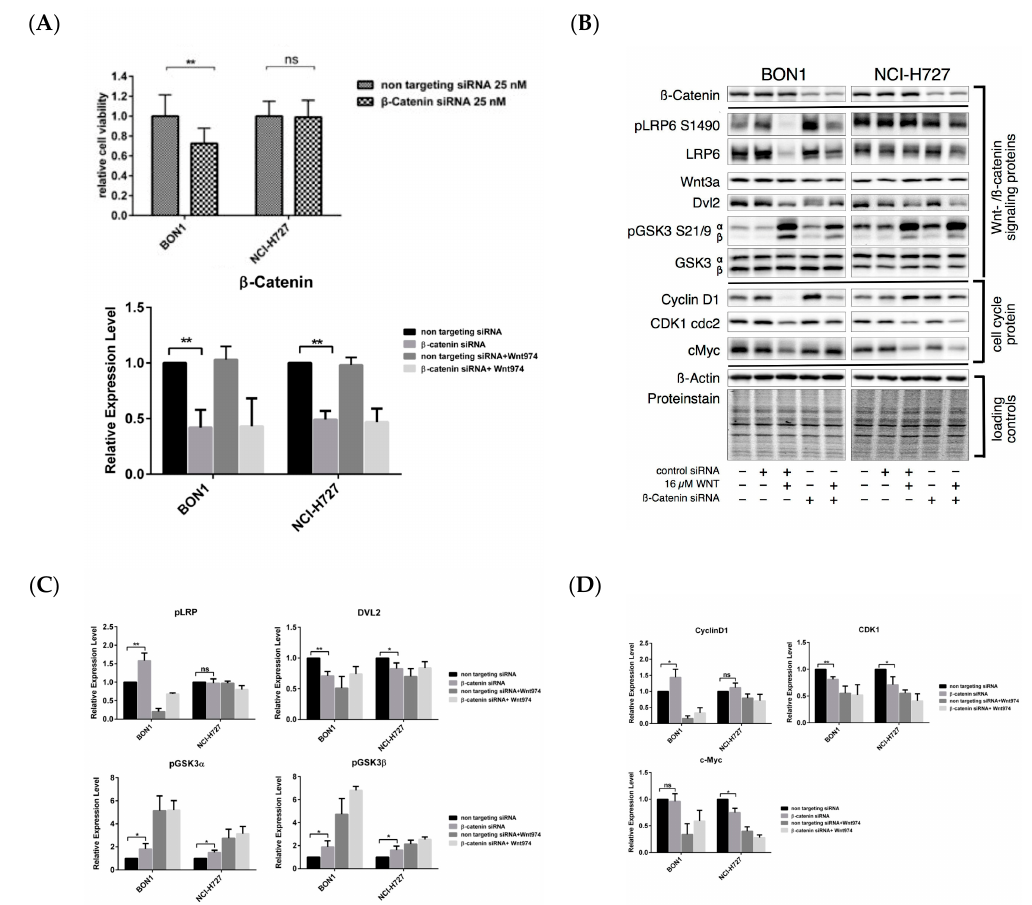
Figure 9. E ff ect of β -catenin siRNA on the reduction of NET cell viability and protein expression. BON1 and NCI-H727 cells transfected with β -catenin siRNA or non-targeting control ( β -actin) siRNA for 72 h and then subjected to cell viability assay and Western blot analysis. ( A ) Cell viability assay and siRNA transfection e ffi cacy. BON1 and NCI-H727 cells were transfected with β -catenin siRNA or non-targeting control ( β -actin) siRNA for 72h and then subjected to the cell viability assay. * p < 0.05 and ** p < 0.01 compared versus non-targeting control ( β -actin) siRNA. Transfection with β -catenin siRNA caused downregulation of β -catenin protein expression, as shown by densitometric quantification of Western blot data. ( B ) Western blot. BON1 and NCI-H727 cells transfected with β -catenin siRNA or non-targeting control ( β -actin) siRNA for 72h and then subjected to Western blot analysis. A representative Western blot is shown. Equal protein loading was verified in all Western blots by normalization to the total protein staining and by the housekeeping protein β -actin. ( C , D ) Quantification of Western blot data of β -catenin siRNA with or without WNT974 for the regulation of NET cells. Densitometric quantification of Western blot data was performed. The DMSO control